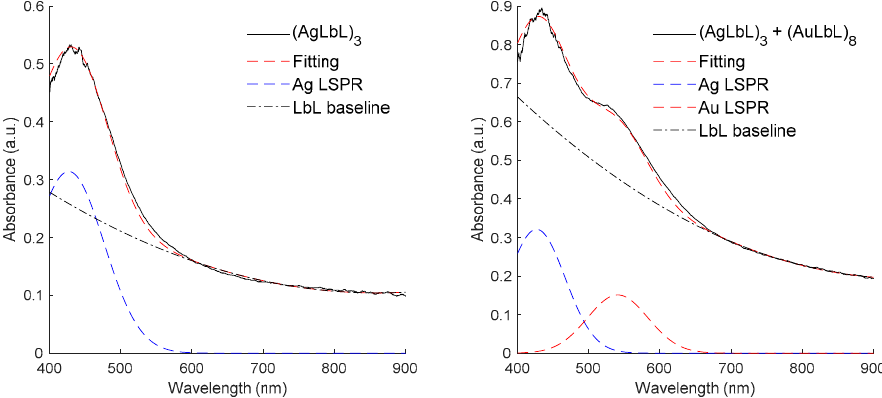
Figure 8. Sequential LbL adsorption of the sensitive coating onto the optical fiber core. ( Left ) Absorbance of (PAH/PAA+AgNPs) 3 coating. The fitting of the Ag LSPR band is displayed using a Gaussian profile. ( Right ) Absorbance of (PAH/PAA-AgNPs) 3 +(PAH/PAA-AuNPs) 8 coating. The contribution of the LSPR of both nanoparticle stacks is clearly visible.